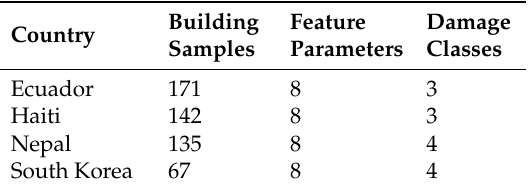
Figure 3. ( a ) Data for Ecuador and Haiti and ( b ) the data for Nepal and South Korea. The distribution of sample buildings over the damage classes is non-uniform. South Korea has the least number of samples among the other datasets. Table 4. Data distribution in the